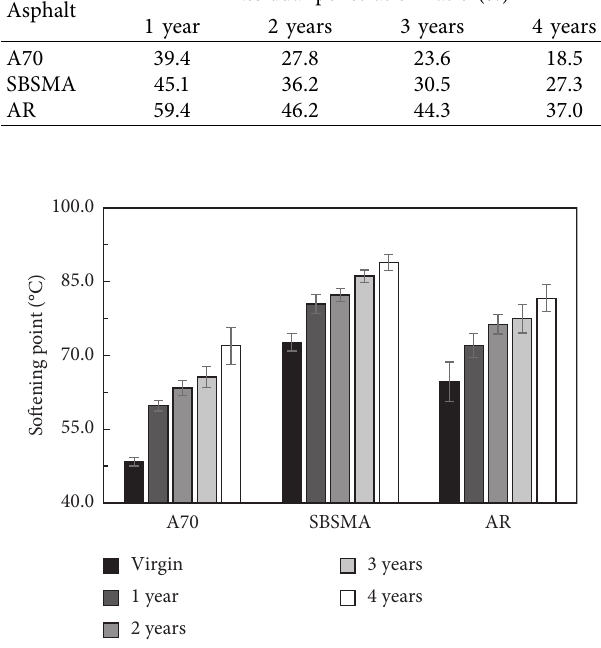
Figure 4: Softening point comparison of asphalts with different weathering times.